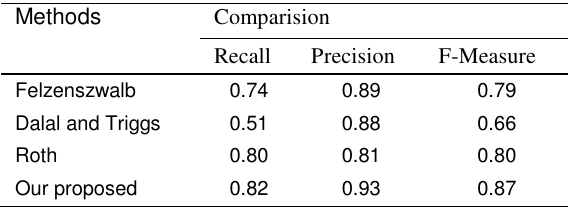
Table 1. The Recall and Precision